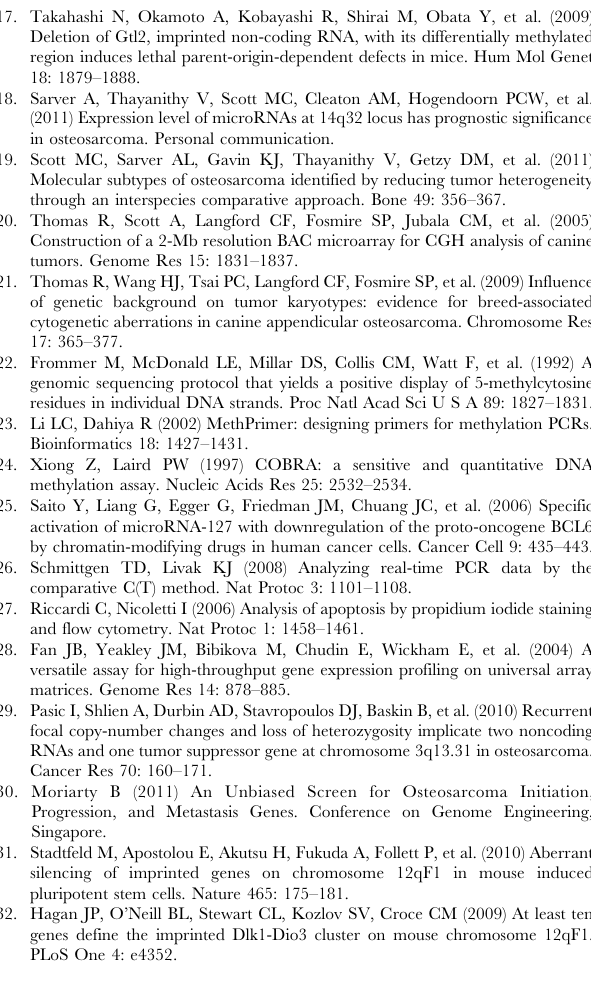
Table S1 List of oligos used for combined bisulfite restriction analyses. Table S2 List of oligos used for ChIP assay. Table S3 List of oligos used for qRT-PCR